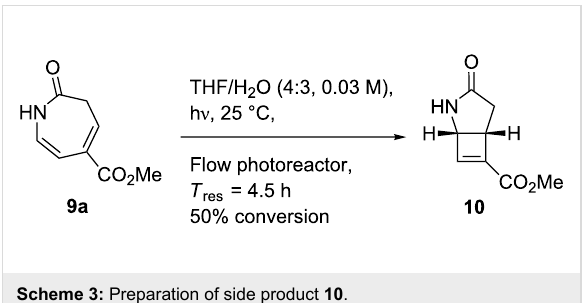
Scheme 3: Preparation of side product 10